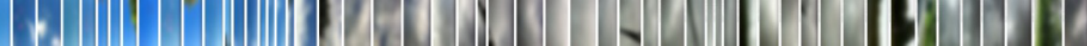
Fig. 10. CitySkin image output: driving for 44 minutes.